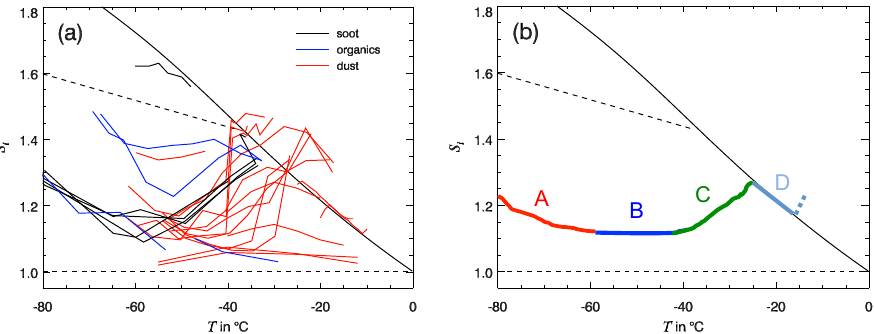
Fig. 19. Isolines of constant nucleation rate coefficients or INAS densities. (a) Selected data from Fig. 2. Each line connects data from one instrument, for one particle type and a constant activated fraction. (b) idealized curve with regimes A to D as discussed in the text.